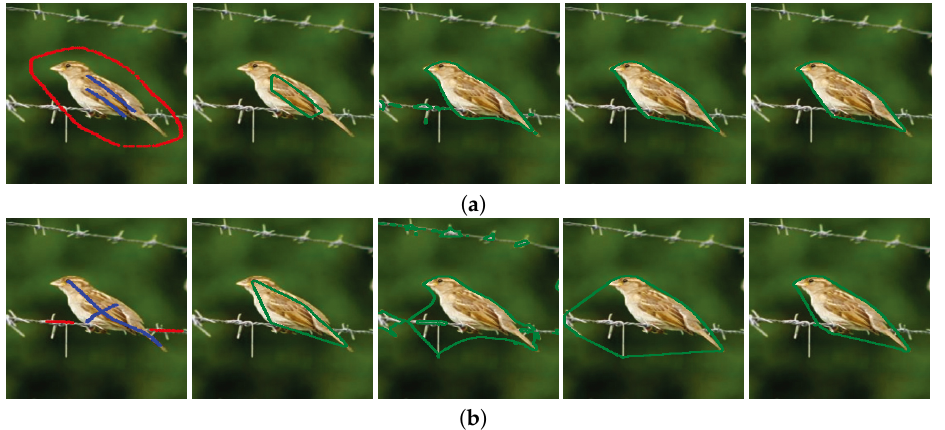
Figure 4. Comparison of image segmentation results with different initial contours, where the first column and the second column shown in ( a , b ) show the original images and the initial contours of foreground regions, respectively, and the last three columns in ( a , b ) are the image segmentation results obtained from the BLF–TV–CS method, the FMF–TV–CS method and our proposed PPA–CS method,